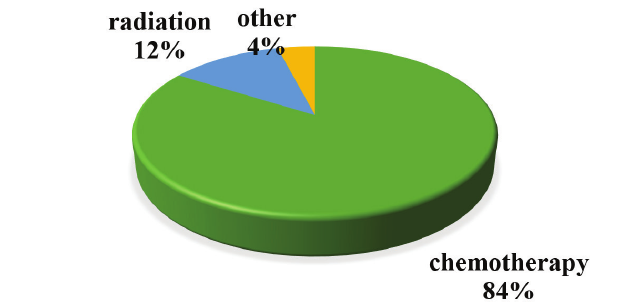
Figure 5. Regime of the cancer patients. Mostly treated based on chemotherapy followed by radiations